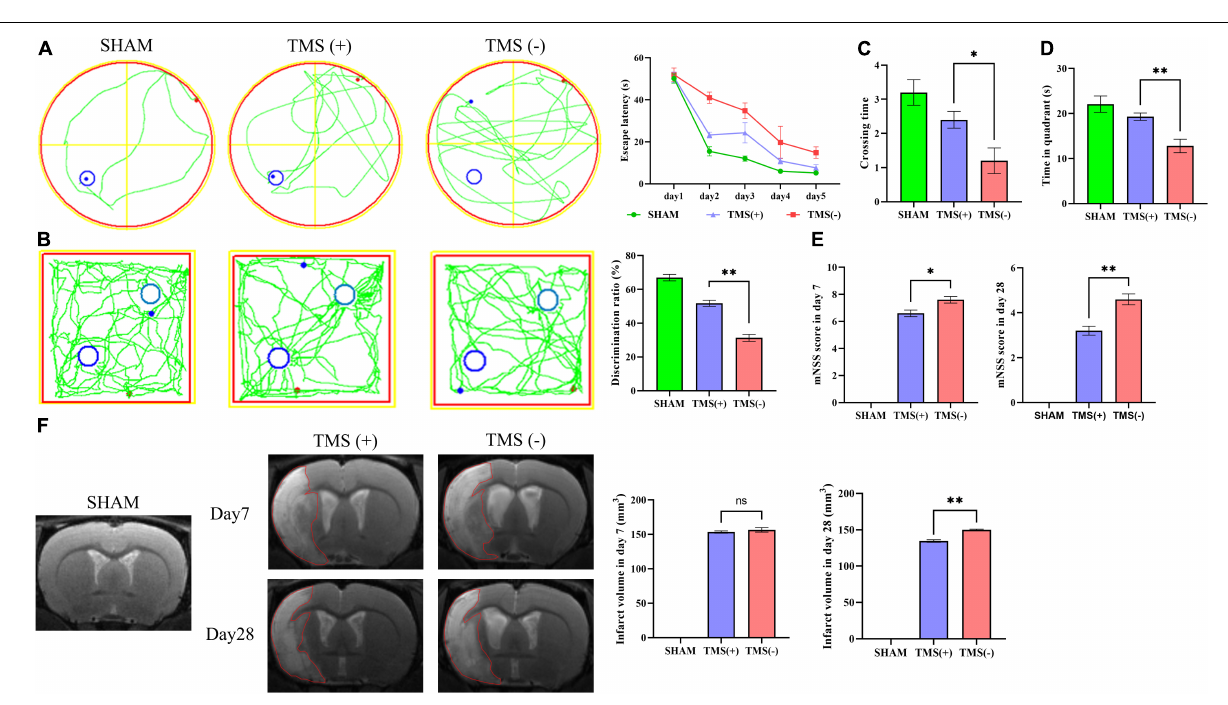
FIGURE 2 | Analysis of neural function recovery of experimental ischemic rats. (A) Representative swimming path of each group in the Morris water maze test and analysis of the escape latency to the platform during the training days of the Morris water maze test ( n = 5 per group). (B) Exploration patterns were recorded in the novel object recognition (NOR) test; green lines are exploring patterns of rats; blue circles represent two different objects. Discrimination ratios were measured ( n = 5 per group). (C) Comparisons of the times crossing the target area and (D) time spent in the target quadrant during the probe trial ( n = 5 per group). (E) Comparison of modified neurological severity scores (mNSS) in each group ( n = 5 per group). (F) Cerebral infarct volume reflected by MRI and comparison of infarct volume in each group ( n = 3 per group). Data are shown as mean ± SEM. Statistical significance was determined with the unpaired Student’s t -test. * P < 0.05 and ** P < 0.01, and ns means no